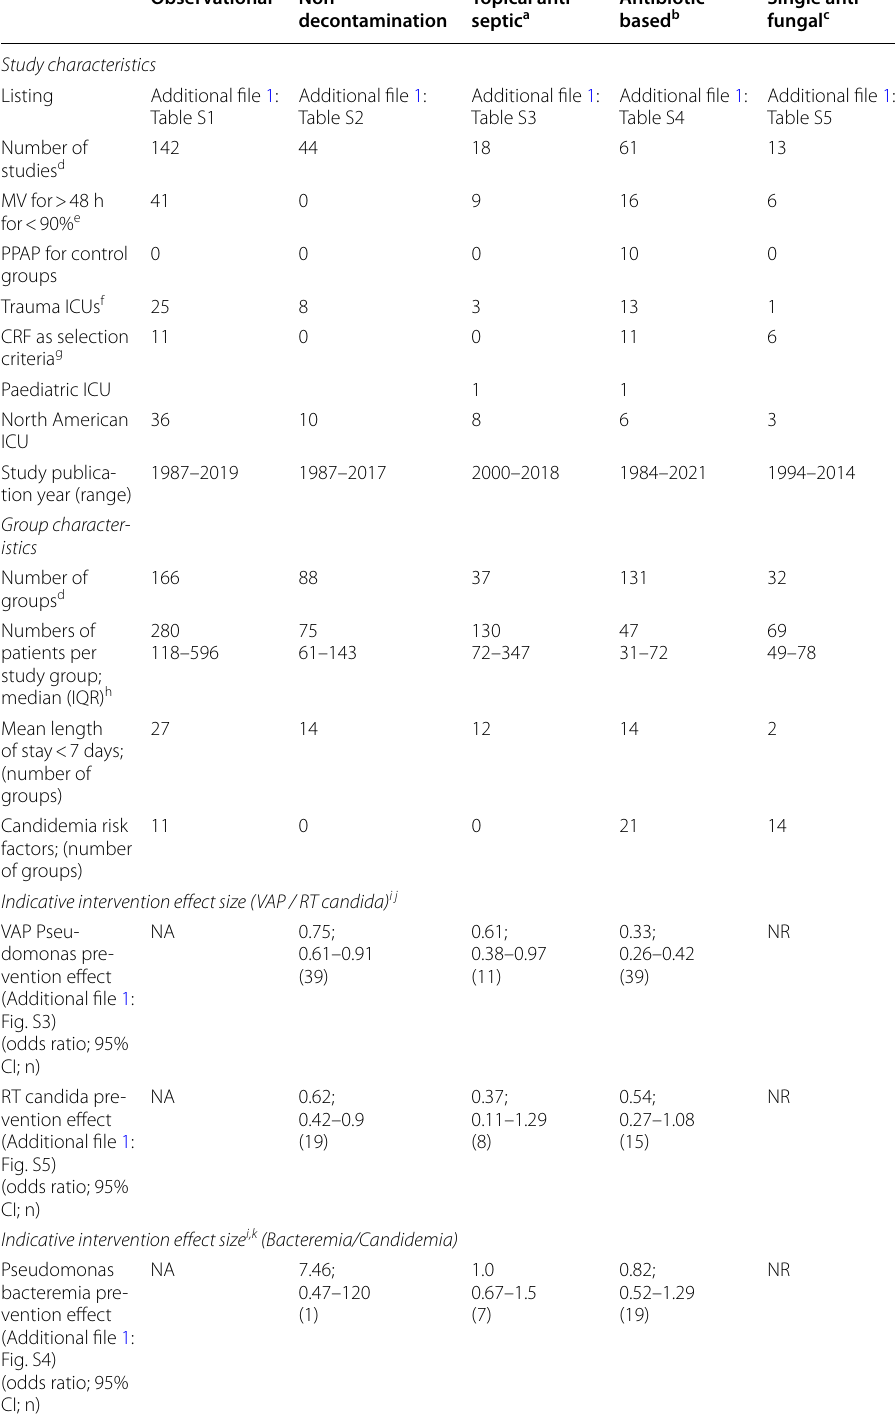
Observational Non-